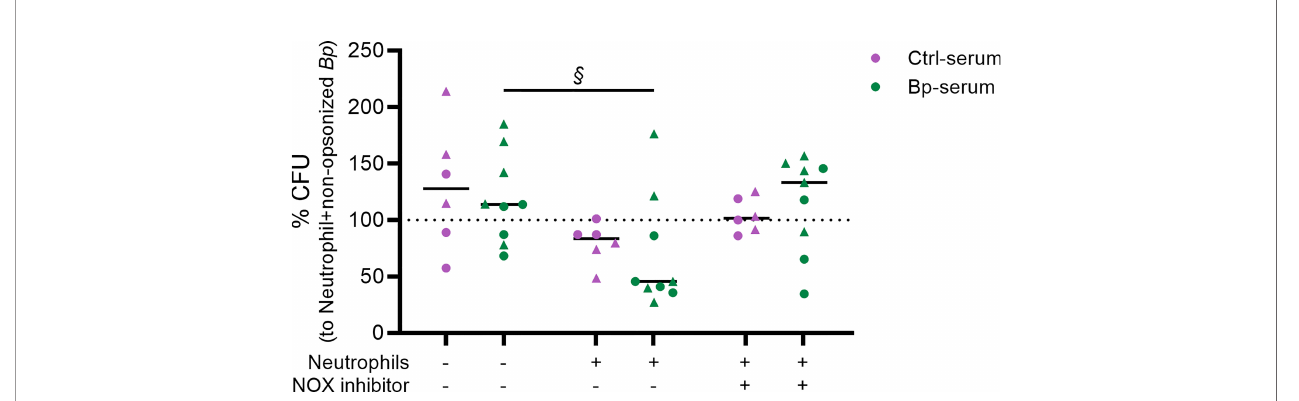
FIGURE 3 | Neutrophil killing of opsonized B. pertussis and the role of ROS in this process. Live B. pertussis (MOI 10) were opsonized with serum samples from healthy controls (Ctrl-serum) shown in purple or from convalescent pertussis ex-patients (BP-serum) (<3 month after diagnosis) in green. The opsonized bacteria were incubated in the presence or absence of neutrophils and/or NOX inhibitor for 4 hours after which neutrophils were lysed and total CFU were determined by plating on BG plates. Bacterial growth is represented as % CFU which was calculated relative to CFU from non-opsonized bacteria incubated with neutrophils (dotted line). § p = 0.075 + ES = 0.605 indicating signi fi cant differences. The data represented are of 2 independent experiments (each represented by symbol shapes).